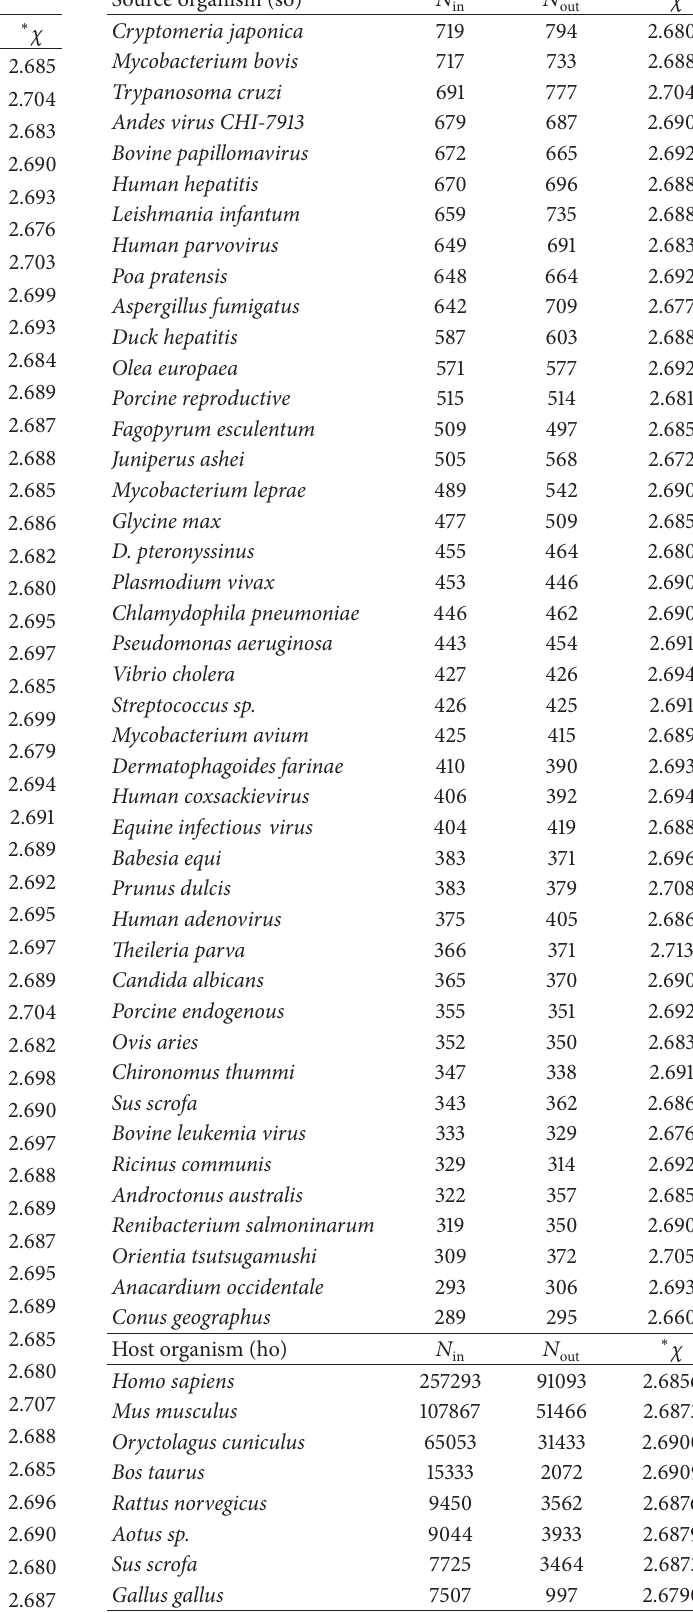
Table2:Averagevaluesandcountofinput-outputcasesfordifferent organisms, process, and